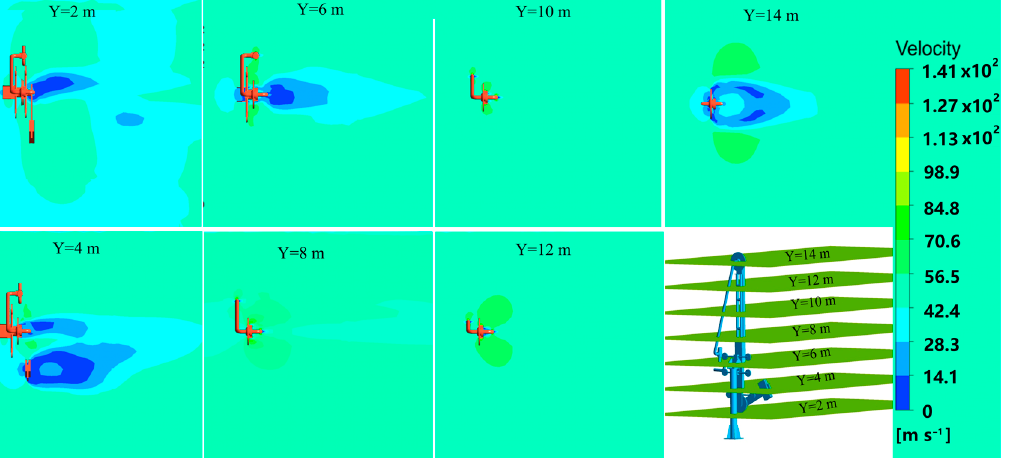
( b ) Figure 17. Stress cloud diagram of topological targets. ( a ) Rope wheels; ( b ) counterweight support.